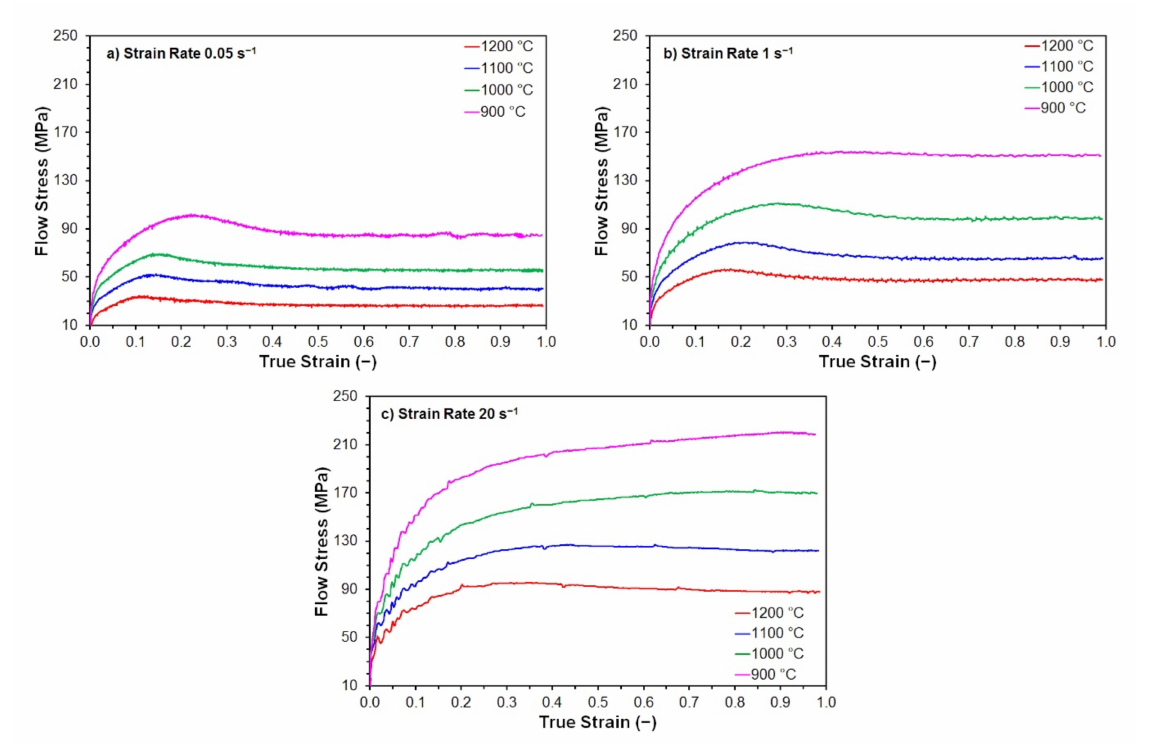
Figure 3. The measured flow stress curves of steel B: ( a ) strain rate 0.05 s − 1 ; ( b ) strain rate 1 s − 1 ; ( c ) strain rate 20 s − 1 .